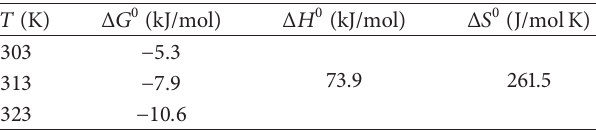
Table 5: Thermodynamic parameters for adsorption of MB onto BG-La-2.